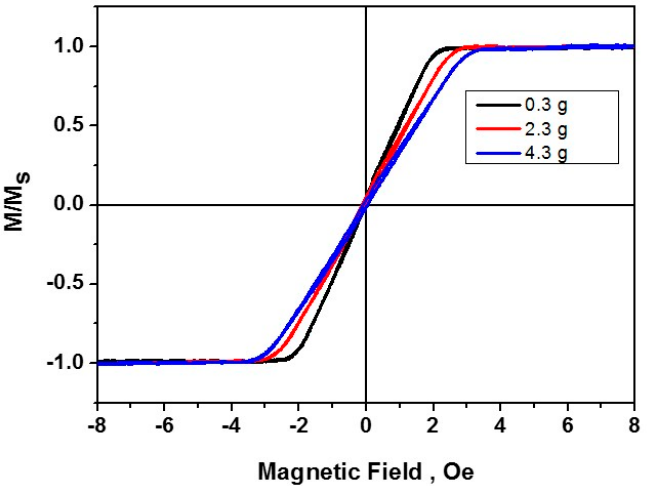
Figure 4. Hysteresis loops of the microwire in the initial state (0.3 g) and under additional mechan- ical load of 2.3 g and 4.3